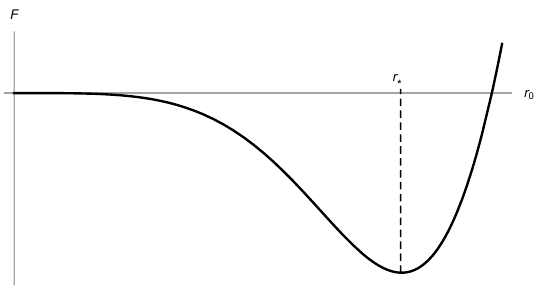
Figure 2 . Free energy for non-extremal